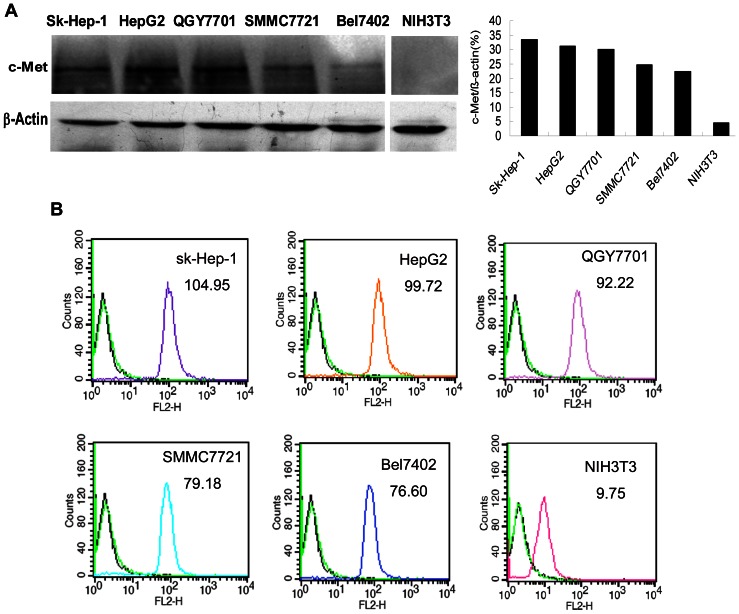
The c-Met expression in each cell line was detected by Western Blot using cell lysate(A) and the binding efficacy of MetFab-DOX on different cells was detected by FACS(B).(A)All HCC cell lines expressed c-Met protein, while no expression of c-Met was observed in NIH3T3 cells. (B) The c-Met expression level was presented as the value of fluorescence intensity by FACS. The number in the upper right was the average fluorescence intensity of each cell lines. Primary antibodies were as follow: no primary (blank line), nor-related control antibody-PE (green line) and MetFab-DOX (colorful line). The result of FACS was conformed to the c-Met expression by WB.